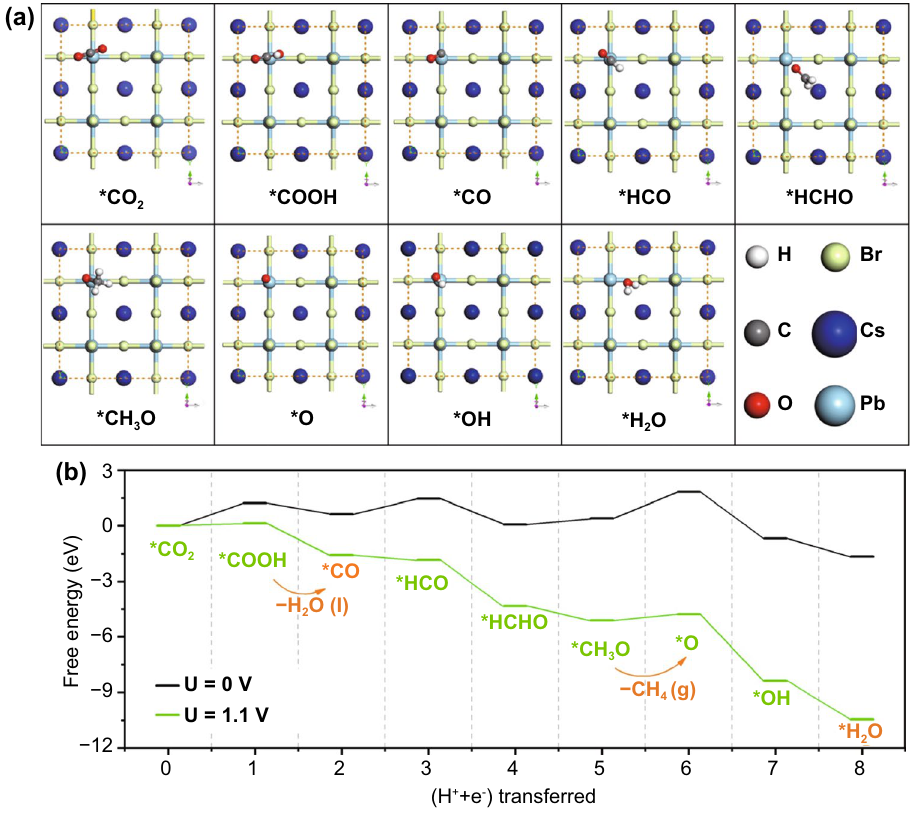
Fig. 6 Formation energy of intermediates. a Binding site configurations for the CsPbBr 3 catalysts ( b ) Energy profiles of all intermediates toward CO and CH 4 . Intermediates for all the binding sites on the Pb sites are calculated and then averaged. The energy profiles are corrected to − 0.0 V and − 1.1 V vs. RHE according to the computational hydrogen